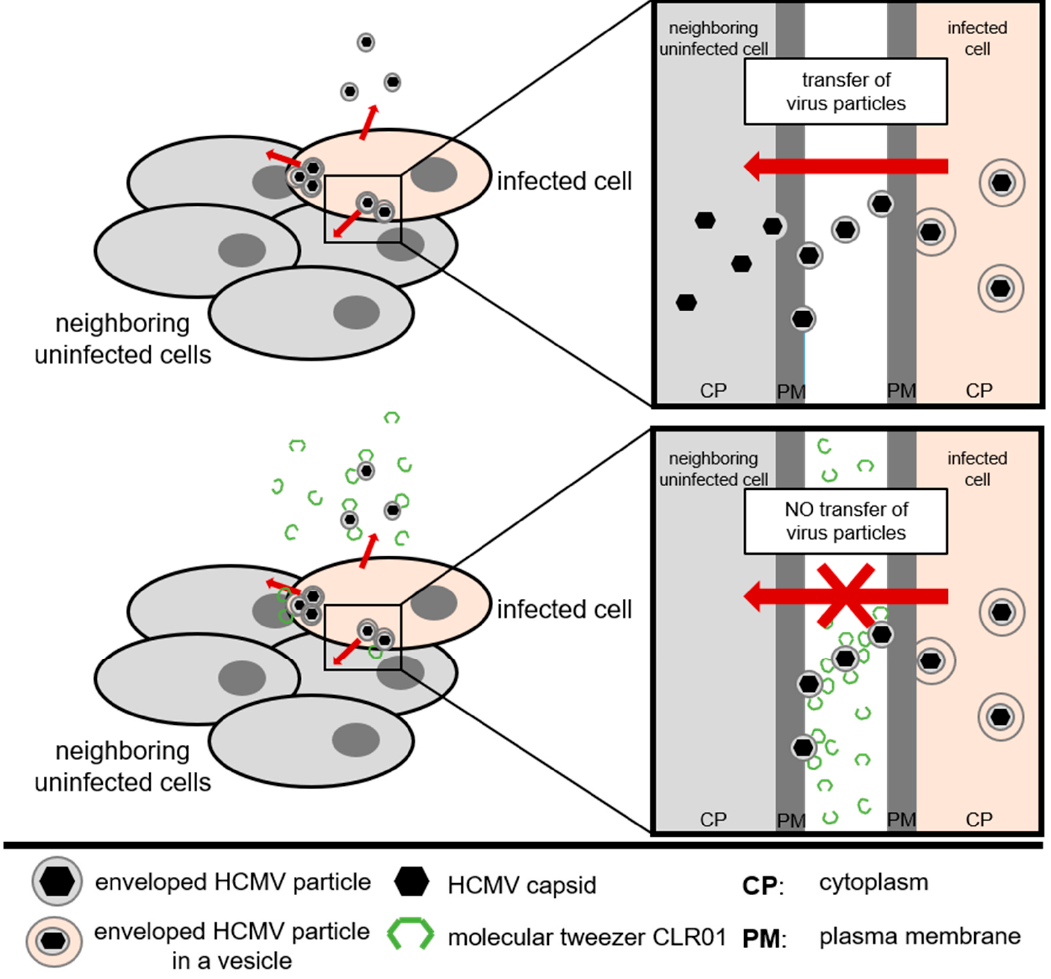
Figure 9. Model of HCMV cell-to-cell spread in human fibroblasts. Upper panel: Unrestricted transfer of enveloped HCMV particles between cell–cell contacts. Lower panel: CLR01 blocks transfer of enveloped HCMV particles between cell–cell contacts.